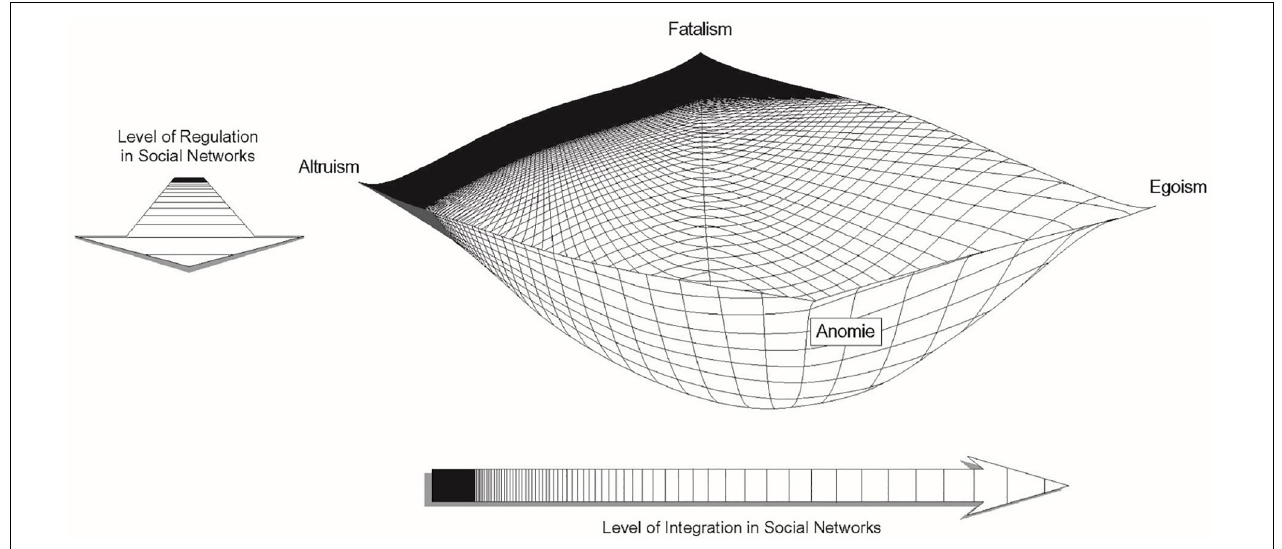
FIGURE 1 | Networks and the Durkheimian theory of